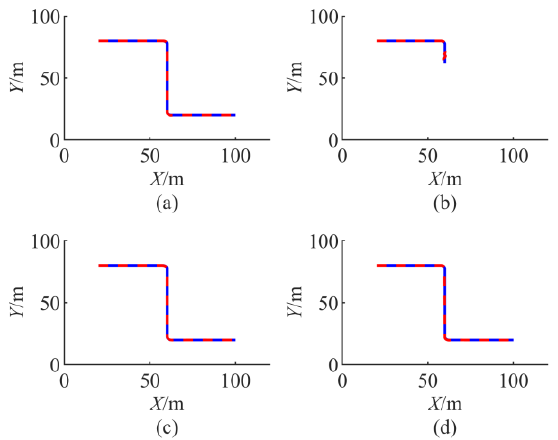
Figure 7. The trajectory when velocity is 3 m/s. The red line is the trajectory. The blue line is the reference path. ( a ) LMPC. ( b ) LEMPC. ( c ) NMPC. ( d ) NEMPC. The blue line is the reference path.